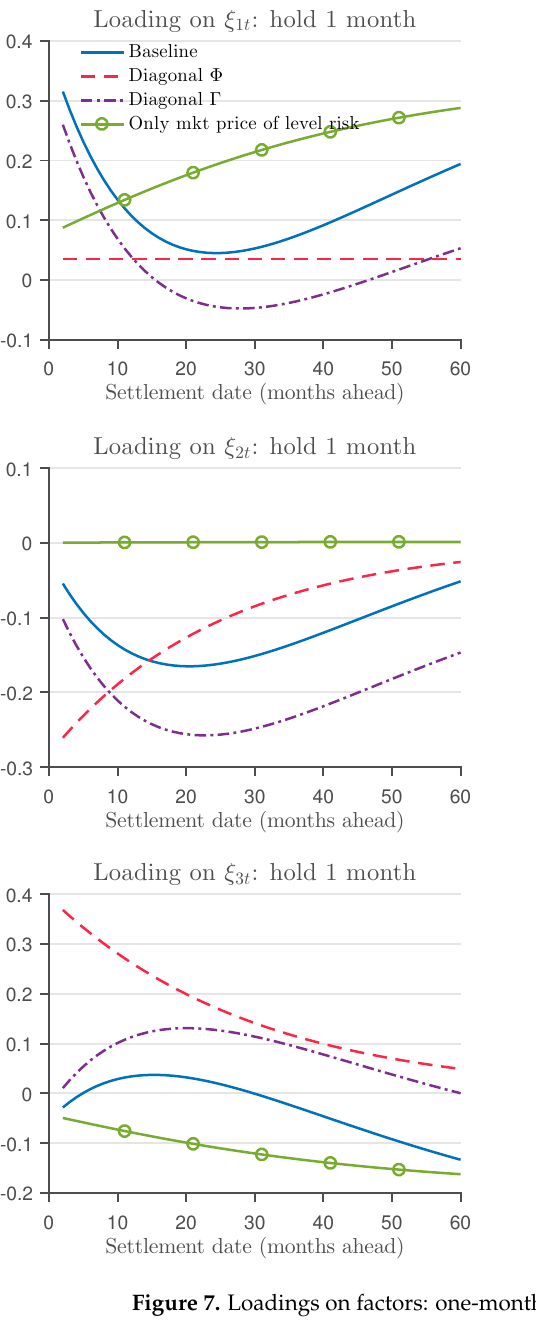
Figure 7. Loadings on factors: one-month and one-year holding forward returns. Figures 8 and 9 show the evolution of the one-month and one-year holding forward risk premiums. Three patterns emerge from the figures. First, the holding forward risk premiums are much smaller than the bond holding risk premiums (excess bond returns). Second, the holding forward premium is also highly contemporaneously correlated with the slope factor ξ 2 t . Third, the difference between the restricted models and the baseline tend to follow a pattern similar to the bond holding risk